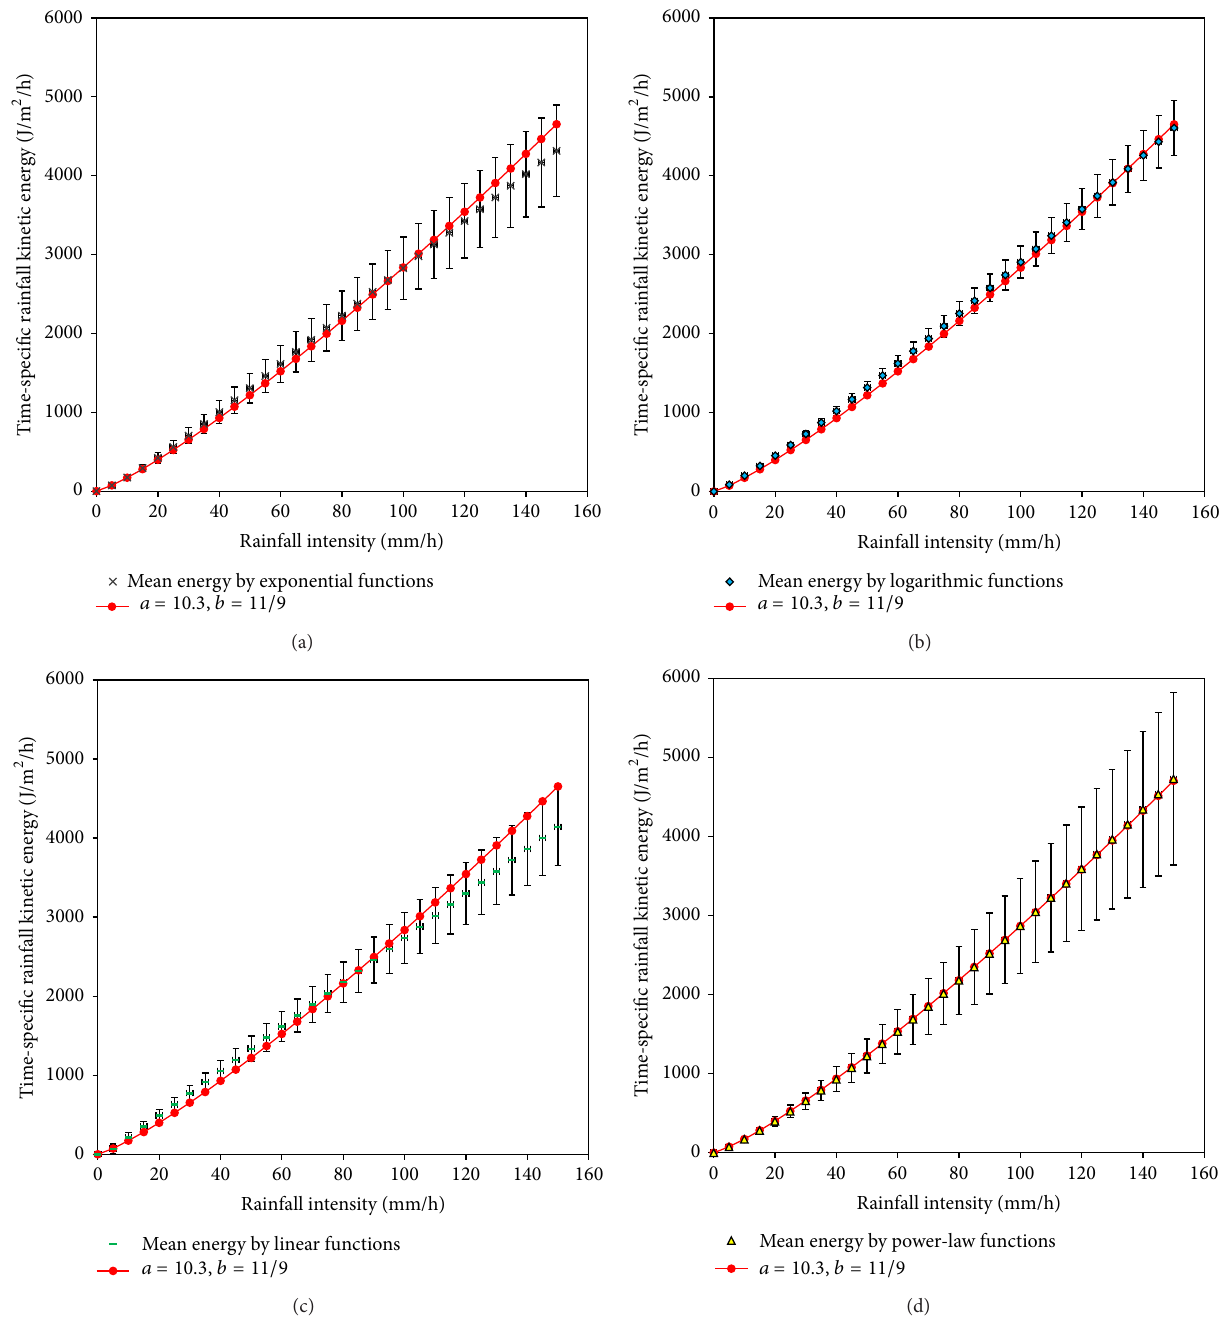
Figure 2: Comparisons of time-specific rainfall kinetic energies calculated by the ideal power law and the exponential functions (a), the logarithmic functions (b), the linear functions (c), and the power-law functions (d).